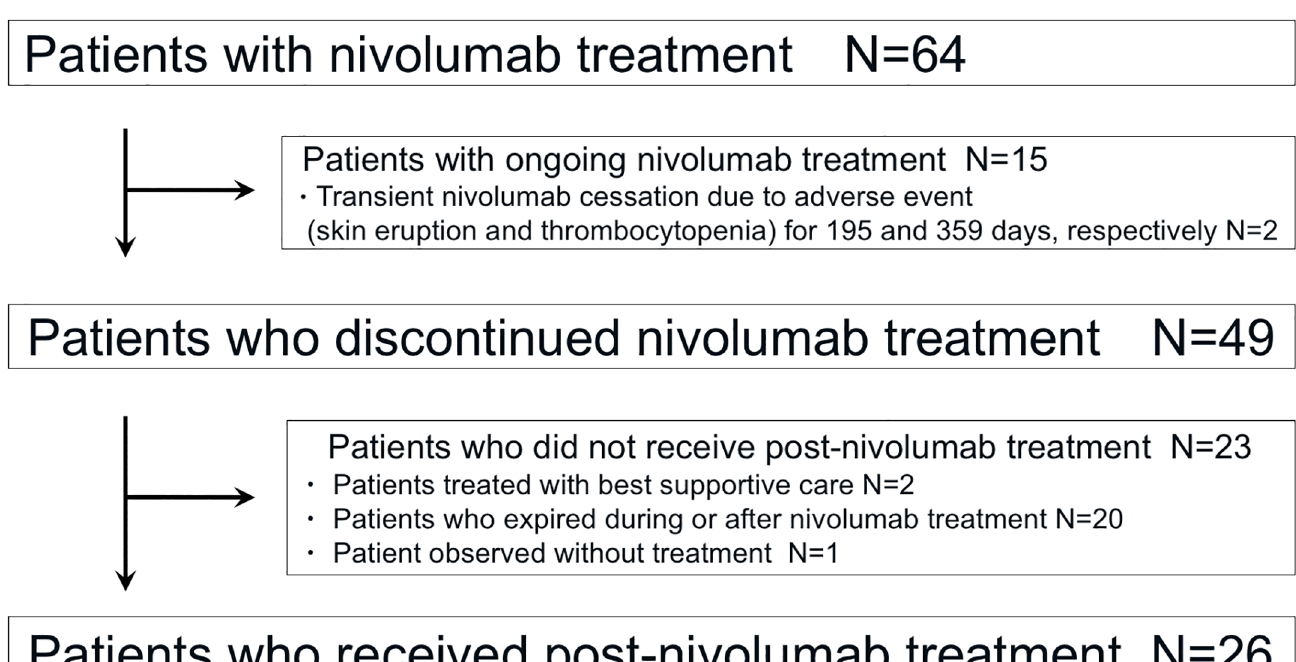
Fig 1. Flow chart of patient